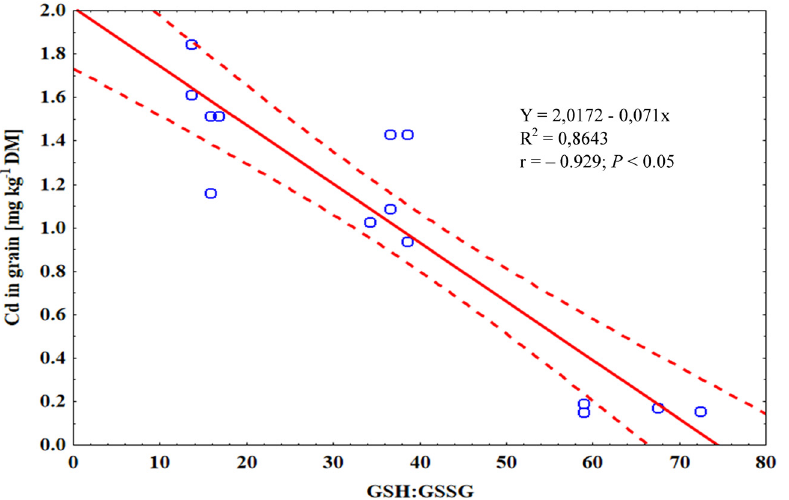
Figure 7: Correlation between Cd accumulation in the grains ( mg kg − 1 DM ) and GSH:GSSG ratio in cv. “ Tamaroi. ” Linear correlation coe ffi cients ( Pearson ’ s ) were assumed statistically signi fi cant at P <